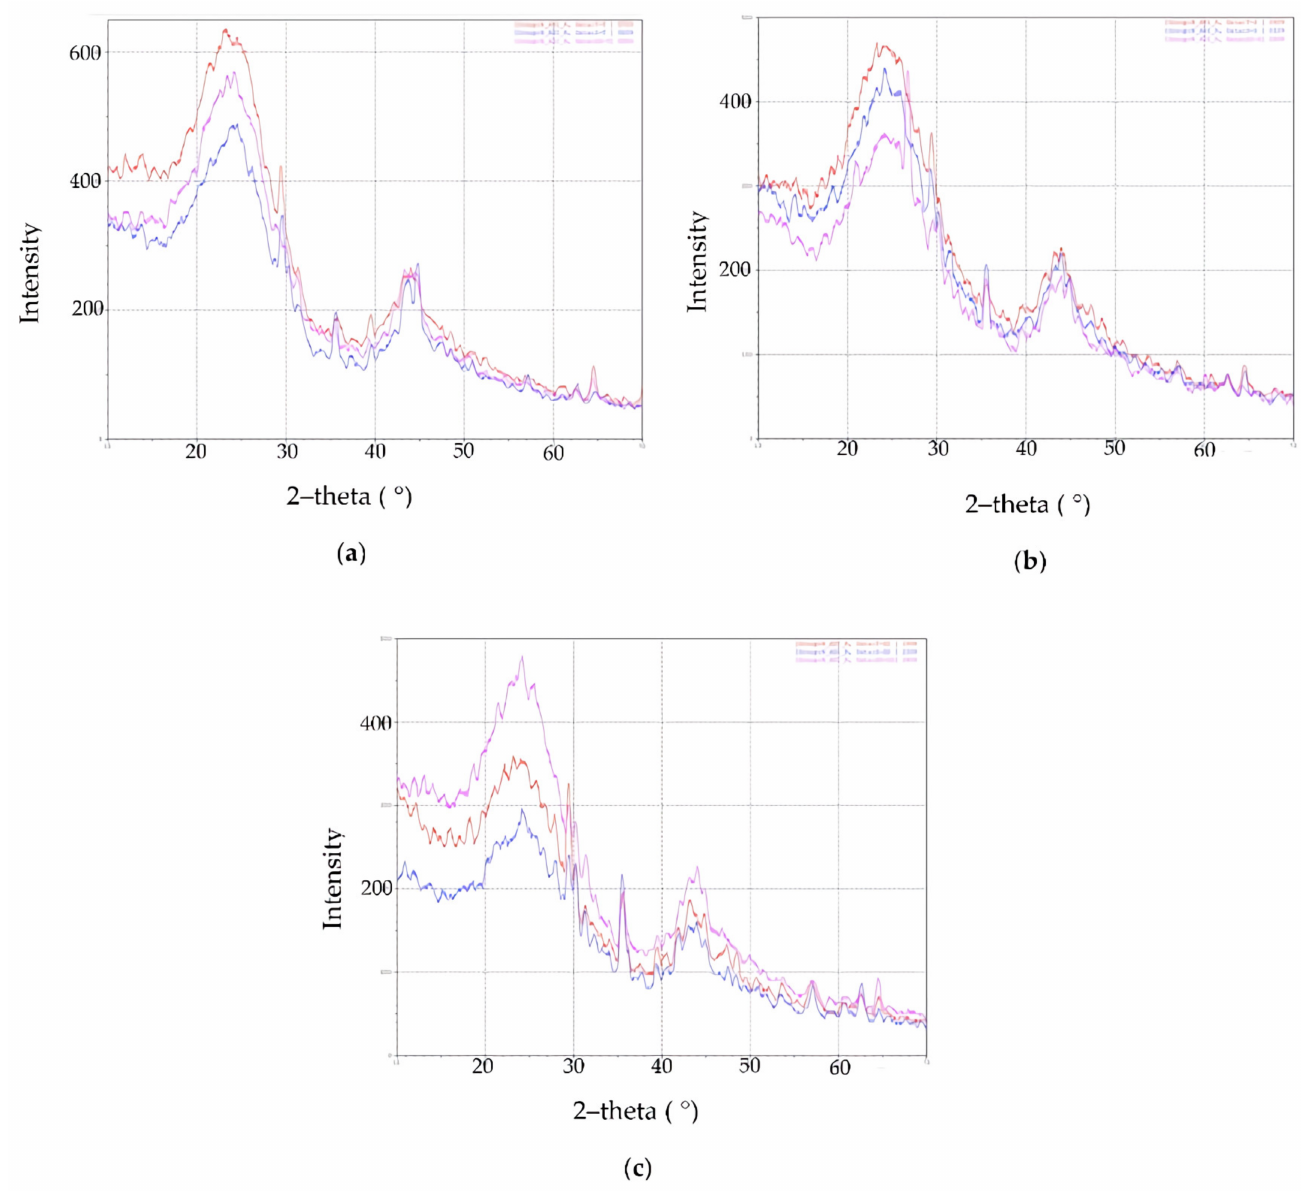
Figure 5. X-ray diffractogram of the prepared activated carbon: ( a ) thermal activation (red line T–T,